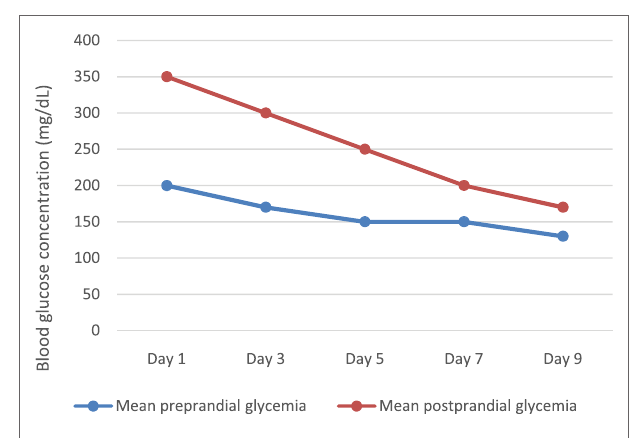
FIGURe 2 | Glycemic variations during intravenous insulin therapy .